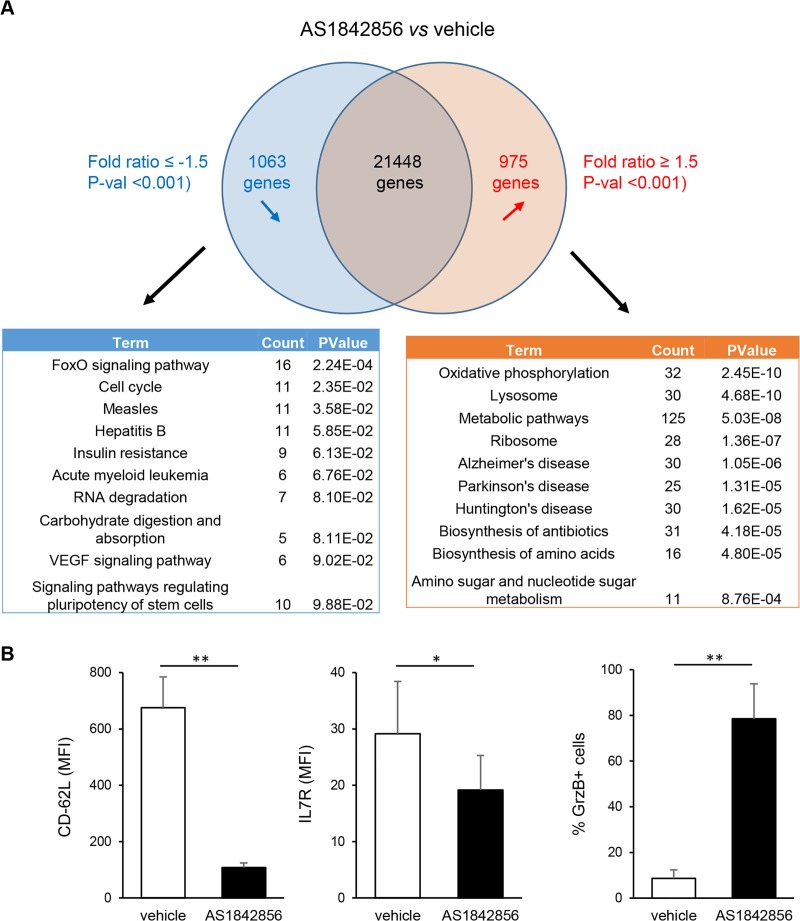
Transcriptome analysis of PBT exposed to AS1842856 treatment.(A) Microarray analyses of PBT from 3 individual donors cultured during 7 days in the presence of the drug (500 nM) or vehicle only were performed. Microarray CEL files were analyzed using the Transcriptome Analysis Console software (ThermoFisher Scientific). On the basis of a <-1.5 and >1.5-fold change cut-off and a P-val <0.01, 1063 genes were down-regulated by AS1842856 and 975 genes were up-regulated. Analysis of these two gene lists using the functional annotation tool of the DAVID Bioinformatics Resources and the KEGG database is also shown, with the most significant pathways altered after AS1842856 treatment. (B) CD62-L, IL-7R and Granzyme B expression were measured by FACS with specific antibodies in PBT exposed to AS1842856 (500nM) or vehicle only during 7 days. Mean results +/- SE obtained with 4 different donors are shown.